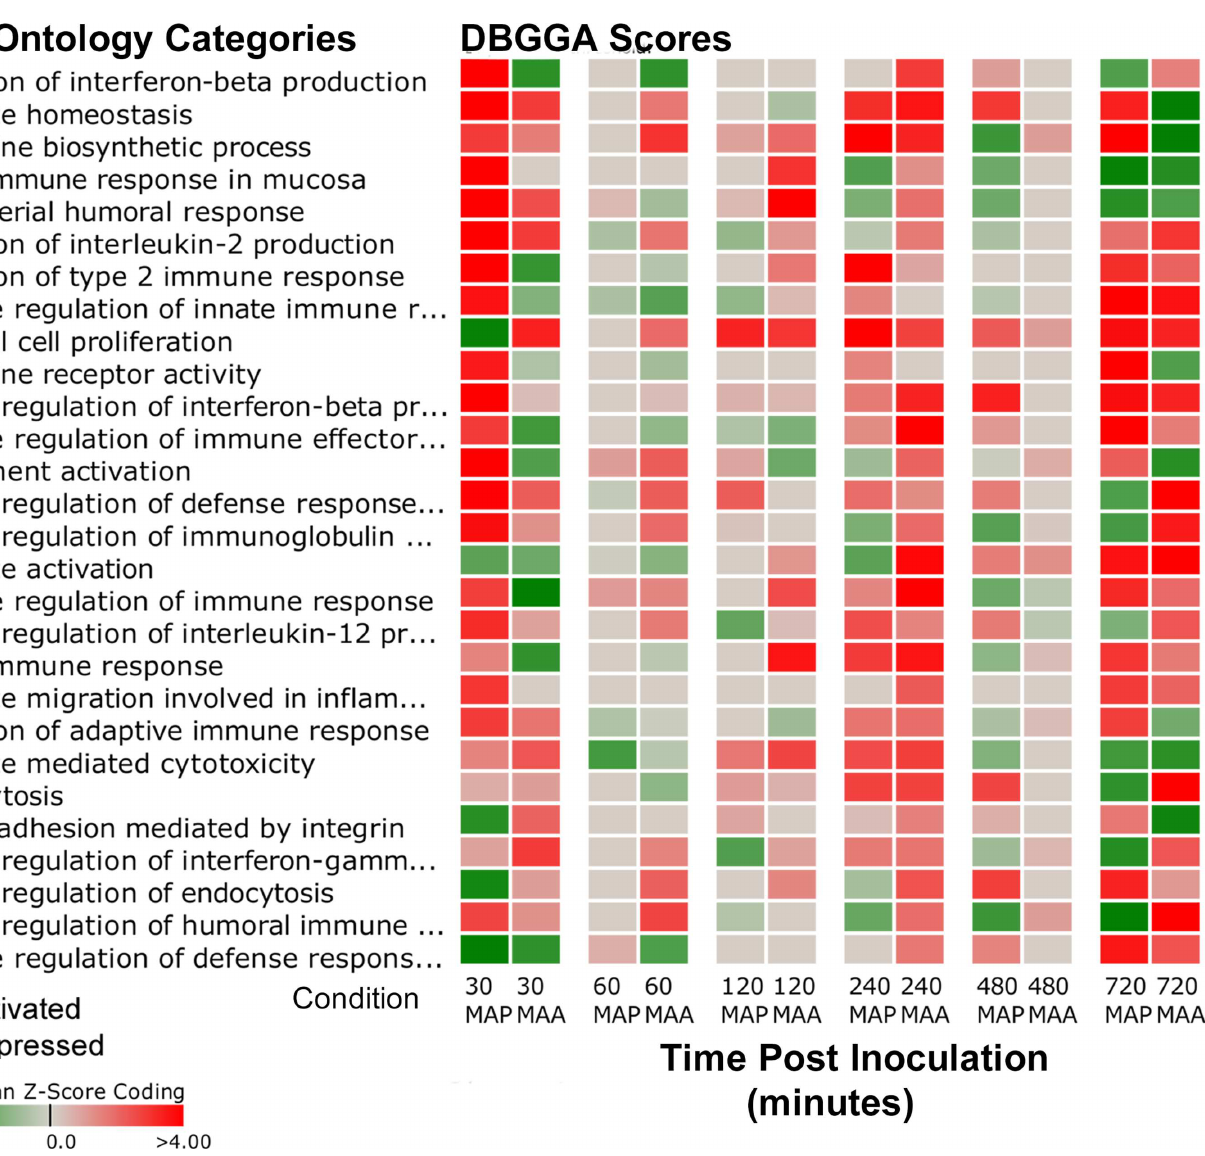
Fig 4. Heatmapof Gene Ontologyscoresof a side-by-sidecomparison (by time point)between MAP vs PBS versus MAA vs PBS. The heatmap comparesMAP significantly perturbedGene Ontologycategoriesto the MAA condition.This subsetof GO categorieswere selectedbased on relevance to the immuneresponseand are top scoringGO categoriesfound significant(DBGGAzscore (cid:21) 2.24)for the MAP condition at 30 minutespost infection. Red indicatesactivation and green indicates repression. The gradient in color indicates magnitudeof perturbation (i.e., higher|zscore|).